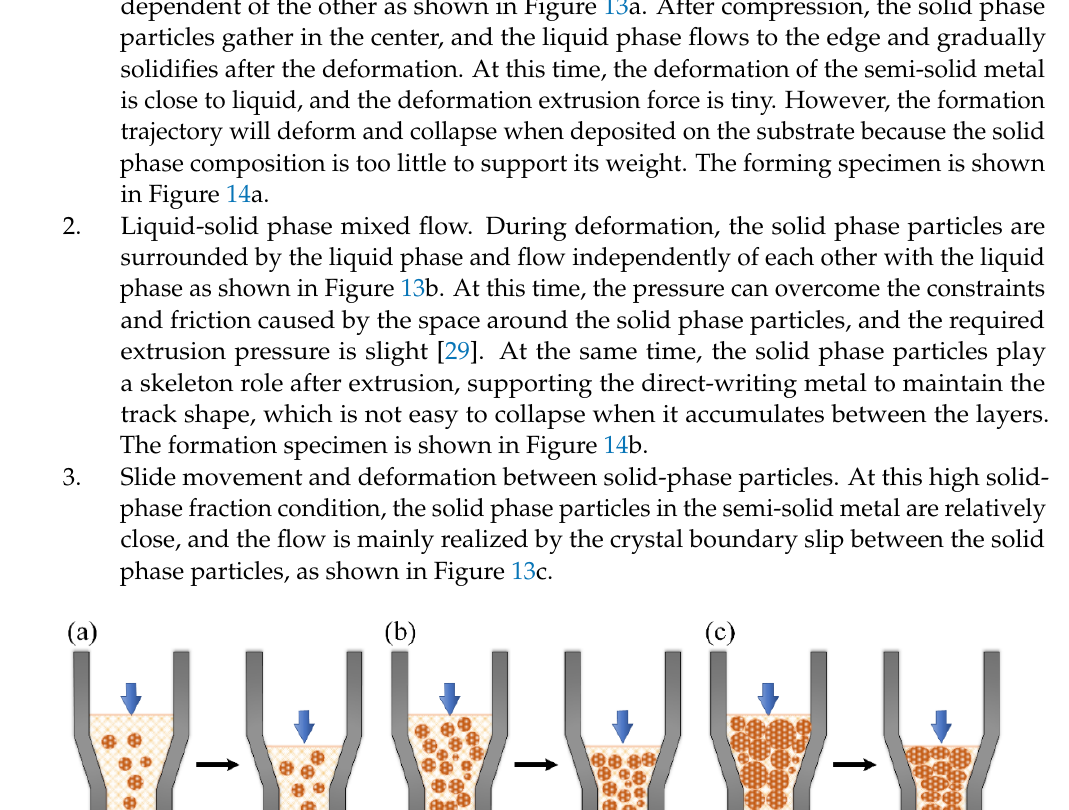
Figure 12. The semi-solid direct writing process.